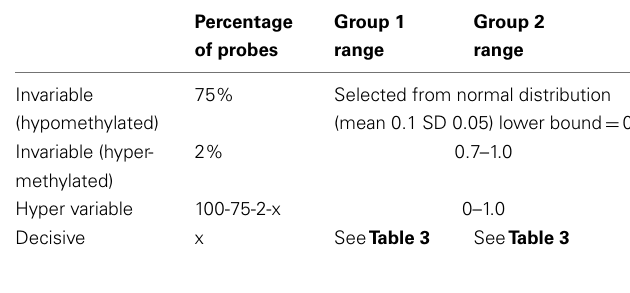
Table 2 | Parameters for simulation of data